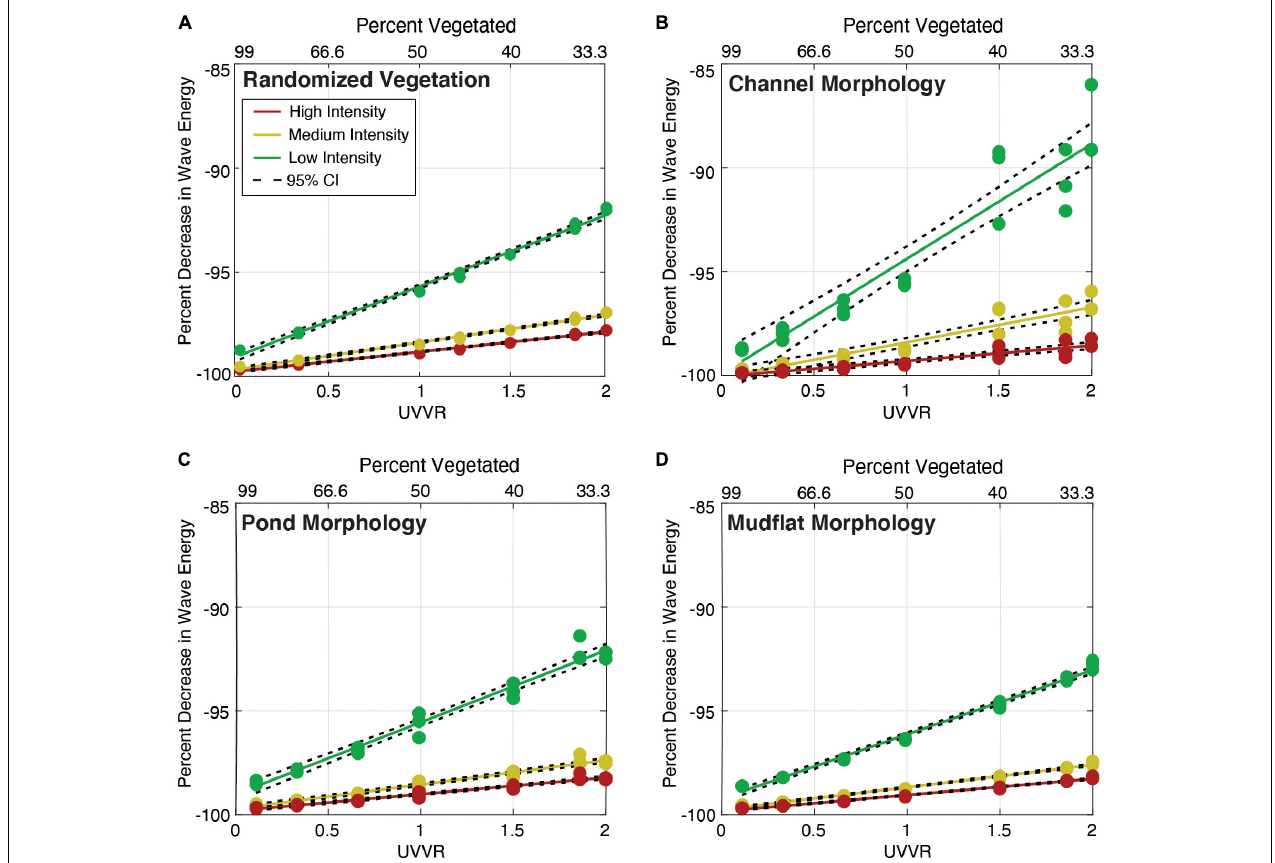
FIGURE 2 | Percent change in wave energy over the first 100 m of marsh for (A) randomized vegetation, (B) channel morphology, (C) pond morphology, and (D) mudflat morphology. Wave intensity scenario is indicated by color, with high-intensity waves (5 m,12 s) in red, medium-intensity waves (2 m, 8 s) in yellow, and low-intensity waves (1 m, 6 s) in green. Model runs with no vegetation and no topography change indicate a percent reduction in wave energy over the first 100 m of marsh of 52, 81, and 84% for low, medium, and high intensity wave scenarios, respectively.